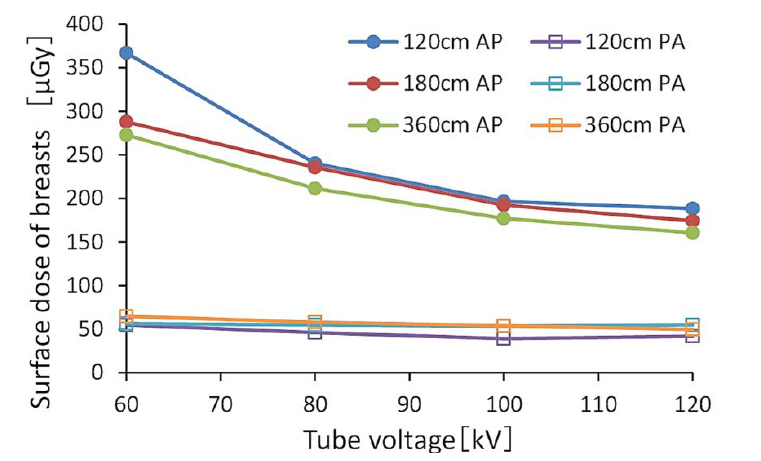
Figure 3. Breast surface doses (BSDs) when changing the tube voltage with a grid. (AP: anteroposterior, PA: posteroanterior).